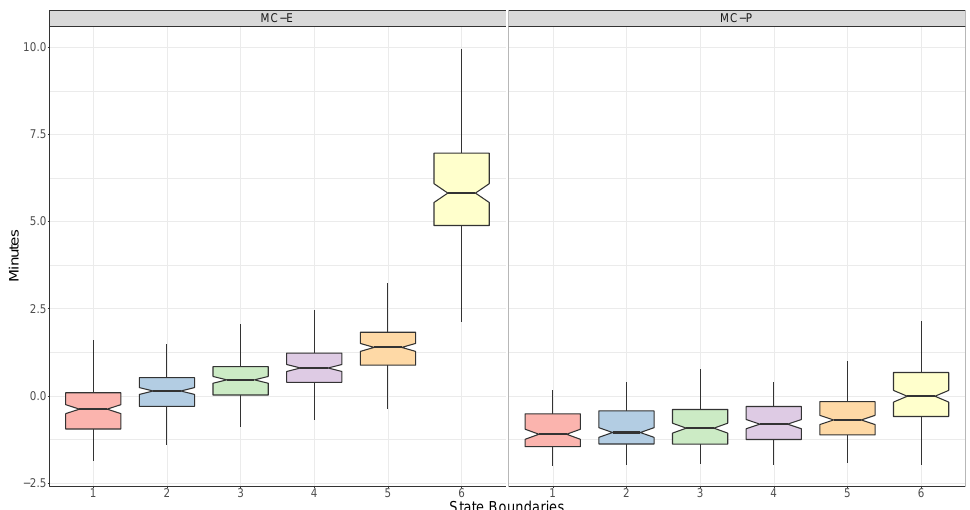
Figure 5. Distribution of elastically defined and calibrated state boundaries for the MC-E ( left ) and MC-P ( right ) with state space dimension five.